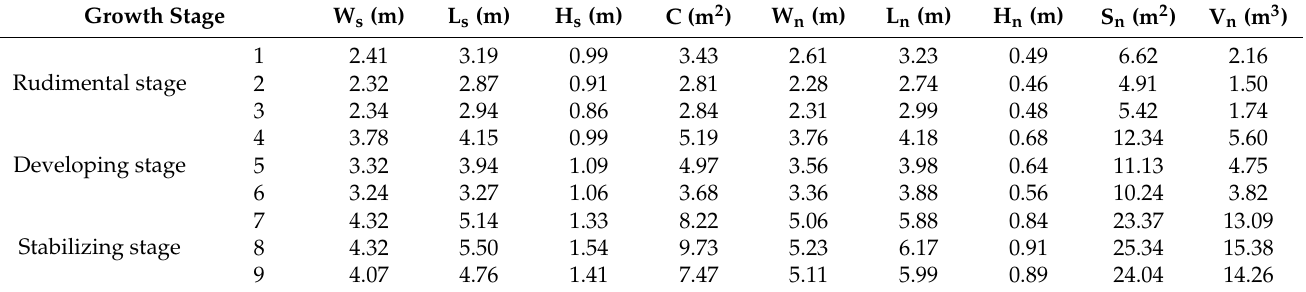
Table 1. Morphological characteristics of shrub and nabkha. Width of shrubs (W s ), length of shrubs (L s ), height of shrubs (H s ), canopy (C), width of nabkhas (W n ), length of nabkhas (L n ), height of nabkha (H n ), base area of nabkhas (S n ), and volume of nabkhas (V n